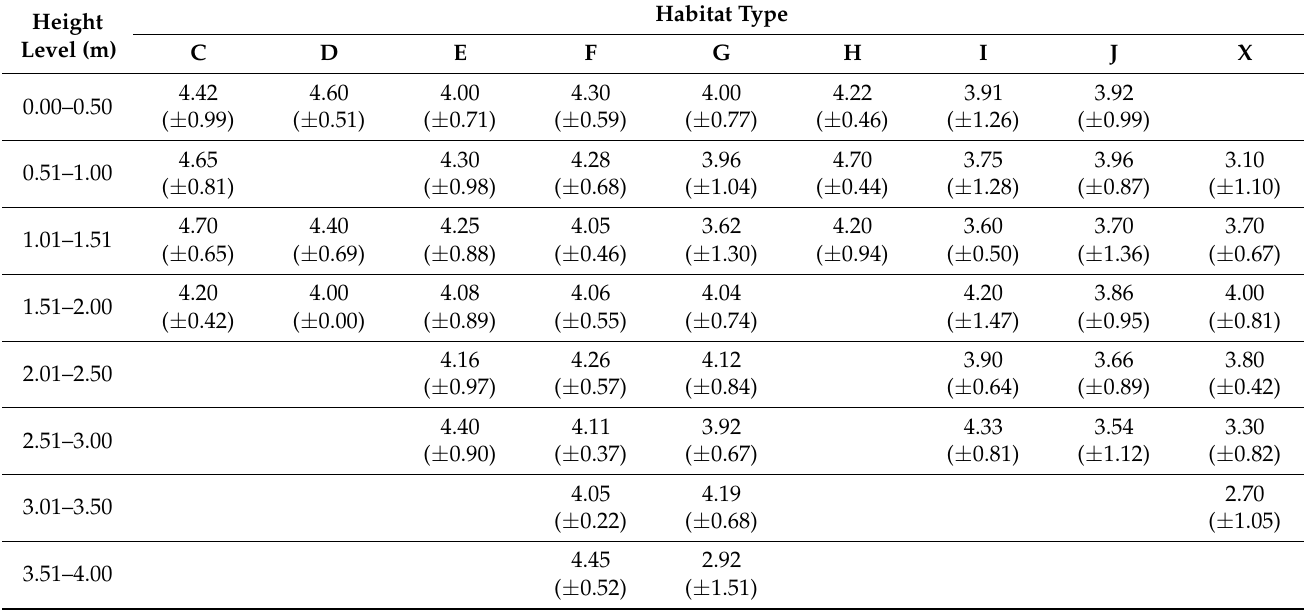
Table 9. The number of seeds per fruit (mean ± SD) of Echinocystis lobata at different height levels in inland surface waters (C); mires, bogs, and fens (D); grasslands and lands dominated by forbs, mosses, or lichens (E); heathland, scrub, and tundra (F); woodland, forest, and other wooded land (G); inland unvegetated or sparsely vegetated habitats (H); regularly or recently cultivated agricultural, horticultural and domestic habitats (I); constructed, industrial, and other artificial habitats (J); habitat complexes (X).